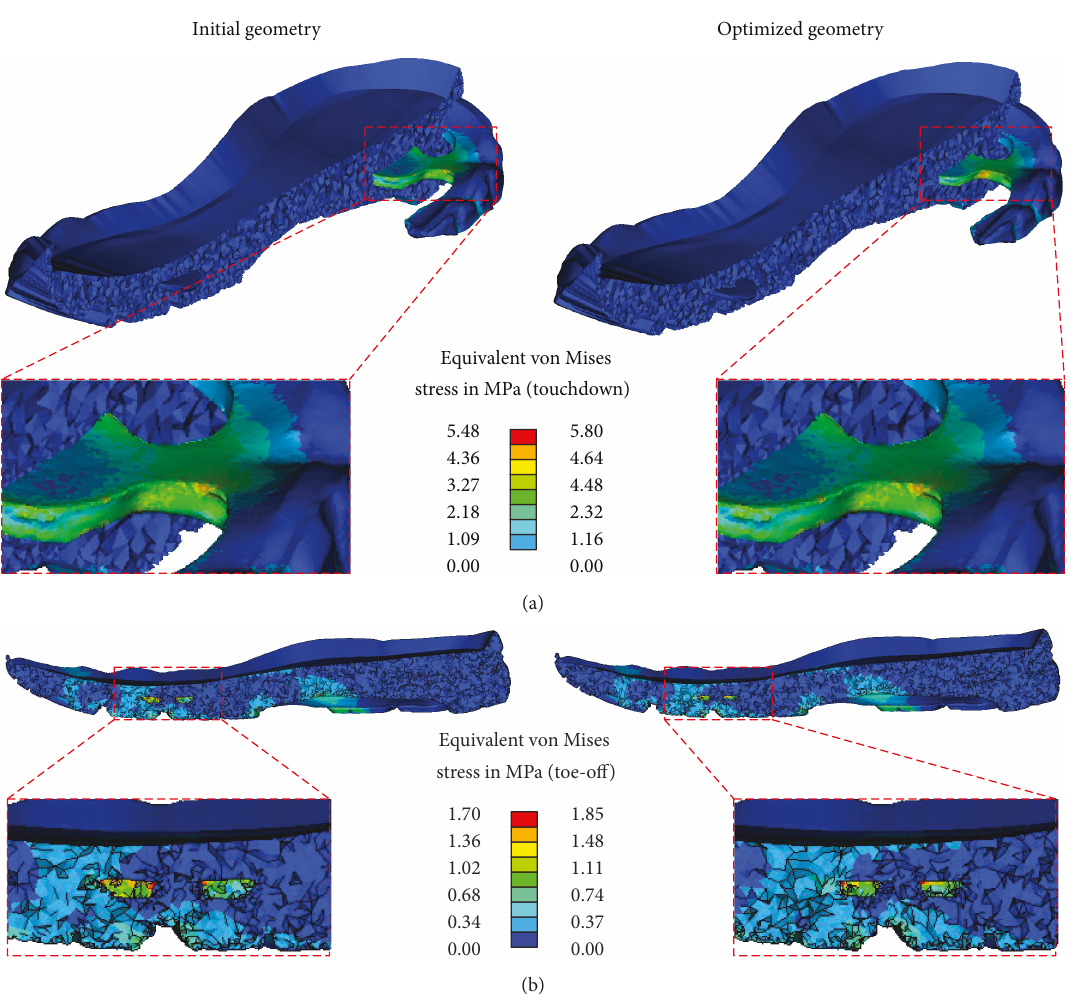
Figure 5: Varying stress distributions in the initial vs. optimized gel pad con fi guration during (a) touchdown and (b) toe-o ff